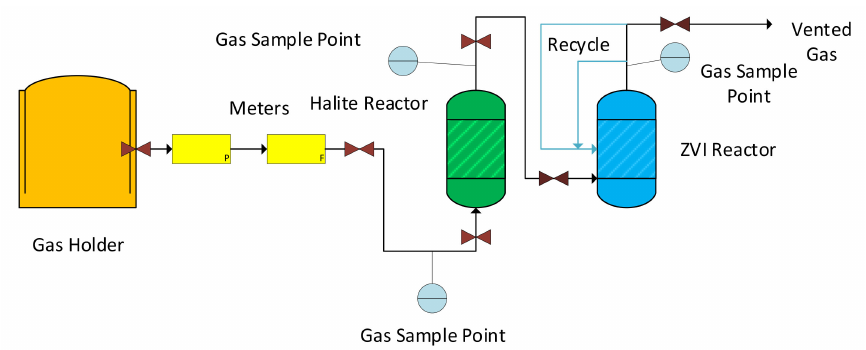
Figure 3. Process flow diagram for the manufacture of ZVI desalination pellets: P = pressure; F = flow rate. Black flow lines are gas. Blue flow lines are recycled water, which was abstracted from the product gas. The Halite Reactor is a fixed bed/packed bed reactor, containing granular halite, which can be supplemented with ZVI. The ZVI Reactor is an aqueous bubble column reactor, containing a static ZVI bed located below the gas